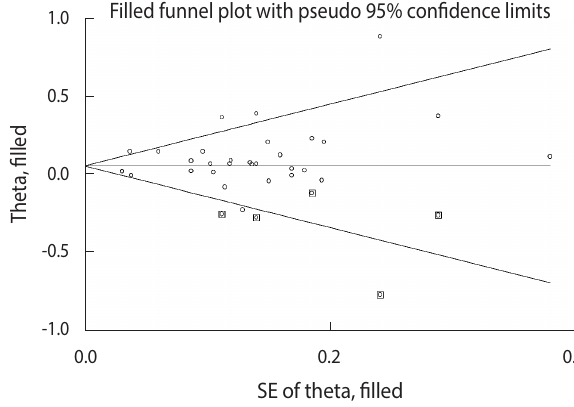
Figure 8. Trim- and- fill analysis of the small-study effect; 5 studies were trimmed and filled. SE, standard